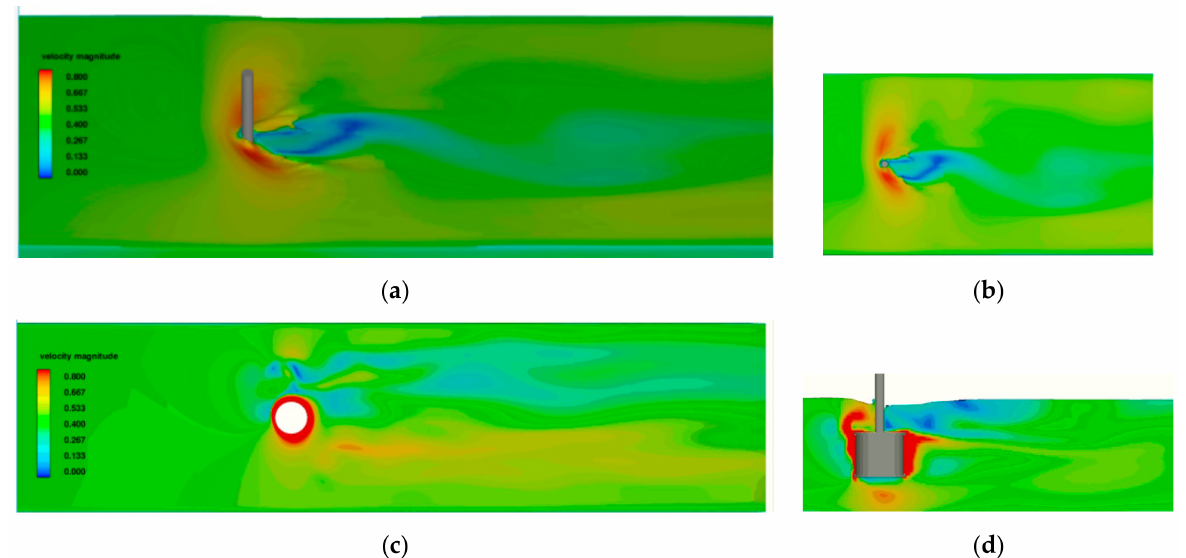
Figure 12. Results of 3D flow simulation for V = 0.40 m/s: ( a ) perspective view of velocity field on the free surface, ( b ) top view of velocity field on the free surface, ( c ) velocity field in the horizontal plane at half-length section of the rotor, and ( d ) velocity field in the rotor symmetry plane.